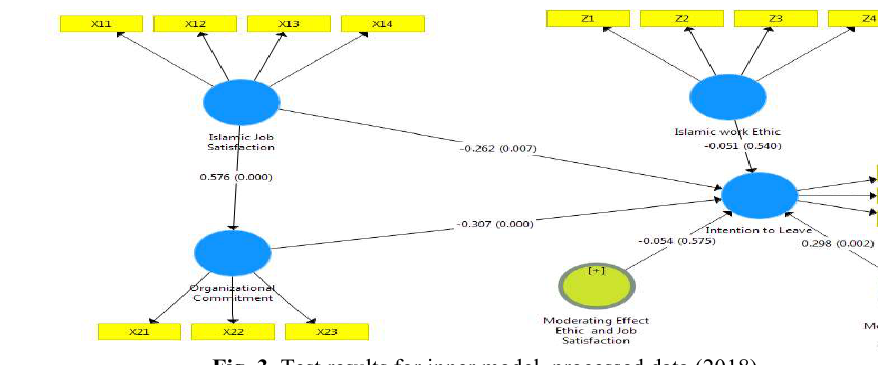
Fig. 3. Test results for inner model, processed data